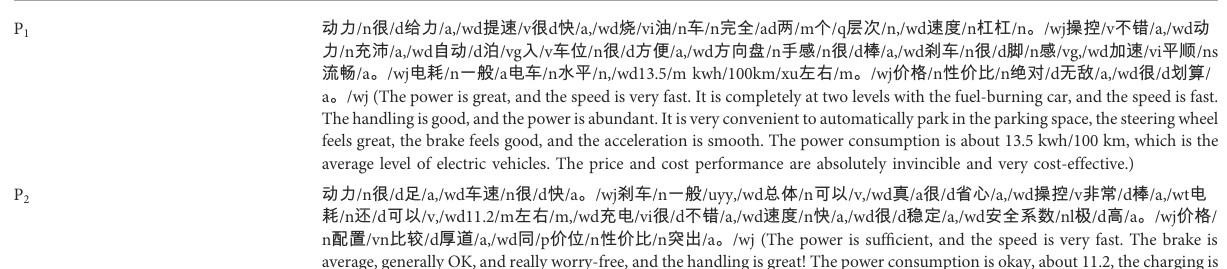
TABLE 6 Processing results of the demand documents of users.